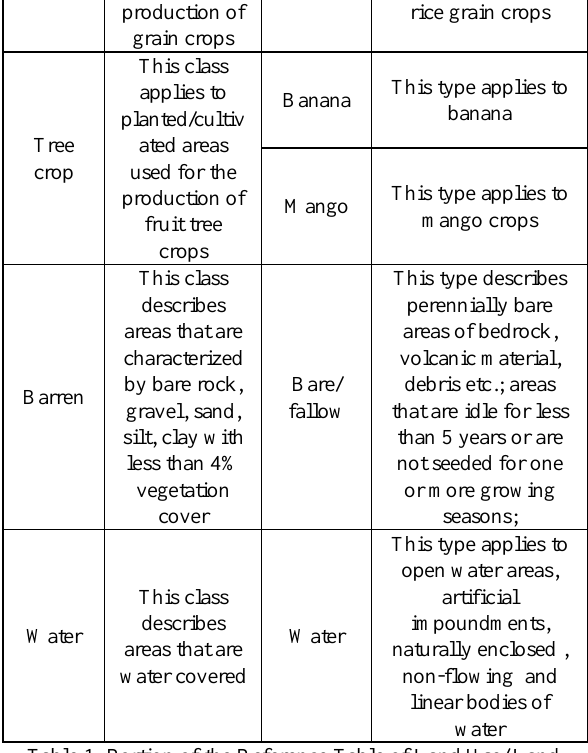
Table 1. Portion of the Reference Table of Land Use/ Land Cover (LULC) for PARMap Schema